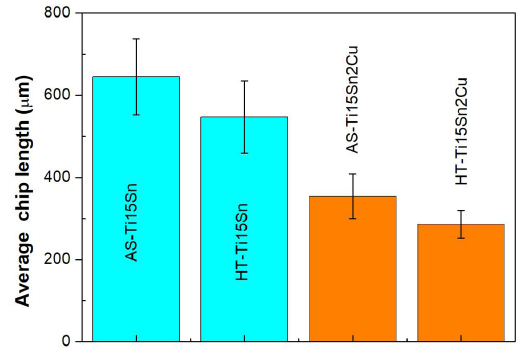
Figure 10. Average length of metal chips of Ti15Sn x Cu